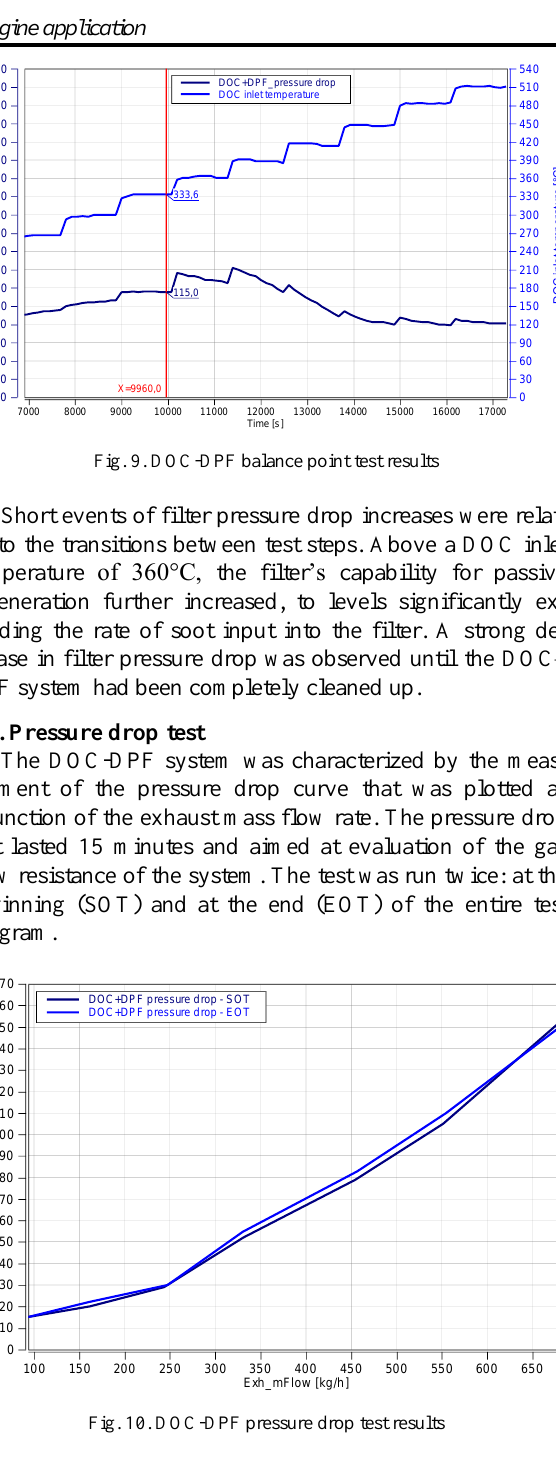
Fig. 10. The maximum DOC–DPF delta pressure